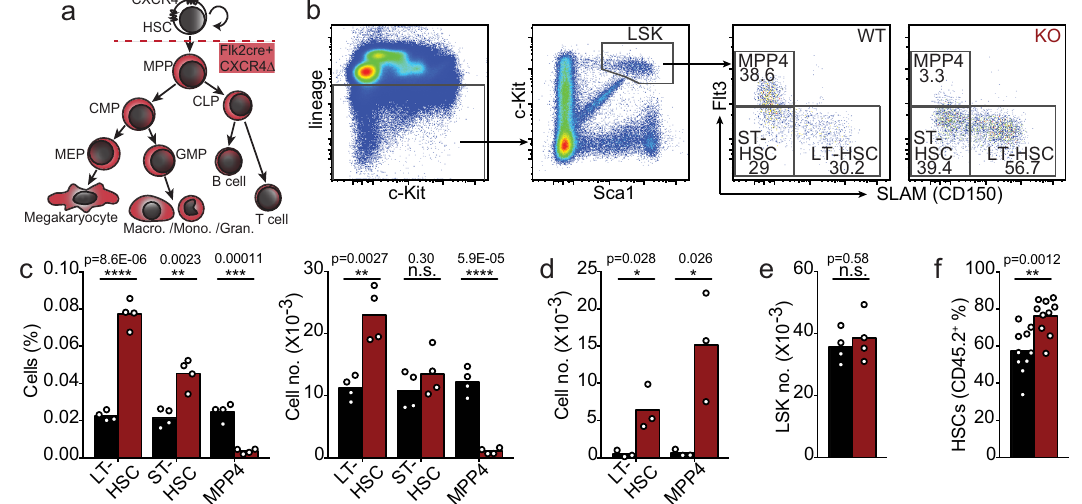
Fig.1|IncreasedHSCnumbersinmicewithCXCR4-de fi cientMPPs.a Schematic representation of CXCR4 deletion in hematopoietic multipotent progenitor cells with a Flk2 -cre transgene. b Gating strategy for LSKs, LT-HSC, ST-HSC, and MPP4 cells. c , d LT-HSC,ST-HSC,andMPP4cellnumbersinbonemarrow( c )andinspleen ( d ). e LSKcellnumberinbonemarrow.InpanelsC-E,cellswerecollectedfromone femurandtibia,orfromspleen,of Flk2-cre.Cxcr4 fl /+ (CTR,black)and Flk2-cre.Cxcr4 fl / fl mice (cKO, red). f HSC chimerism in bone marrow of mice reconstituted with 50%